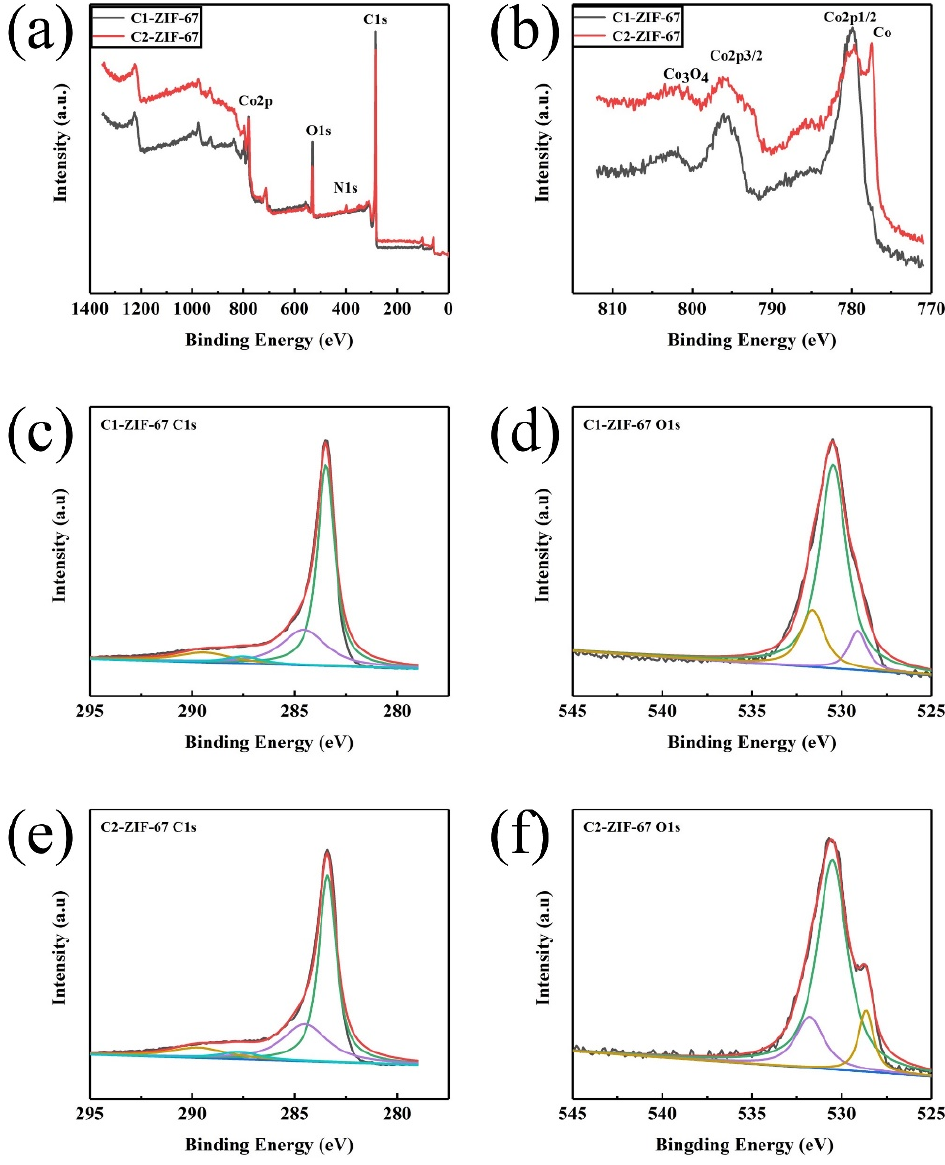
Figure 5. ( a ) XPS spectra of the C1-ZIF-67 and C2-ZIF-67, ( b ) the high-resolution Co 2p XPS spectra of the C1-ZIF-67 and C2-ZIF-67, and the high-resolution XPS spectra of C1-ZIF-67 (C 1s) ( c ), C1-ZIF-67 (O 1s) ( d ), C2-ZIF-67 (C 1s) ( e ) and C2-ZIF-67 (O 1s) ( f ).